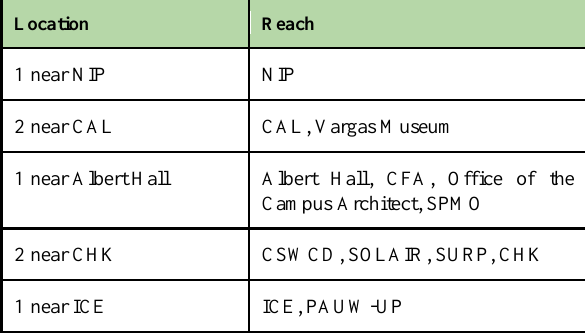
Table 1. Kiosk Locations and their corresponding